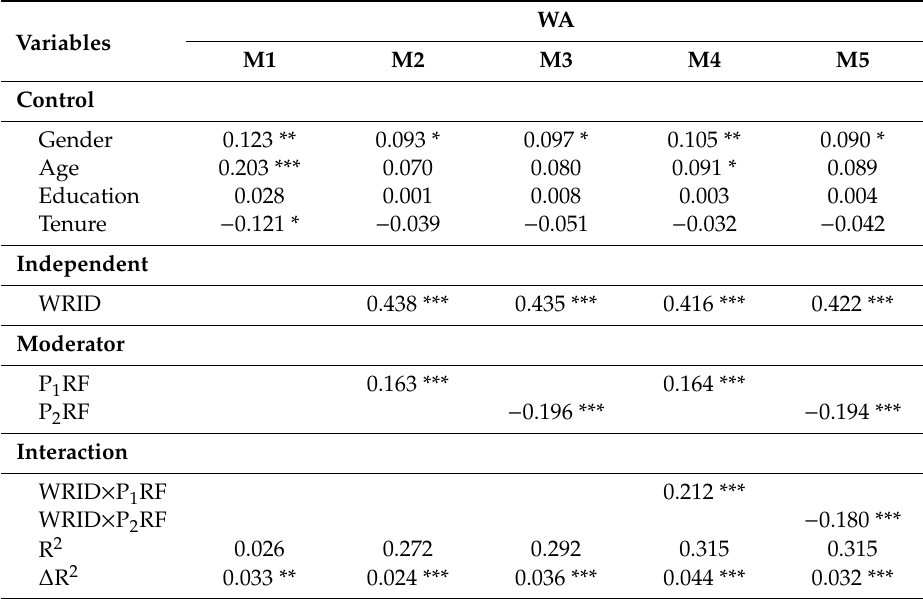
Table 2. Regression results of the moderation